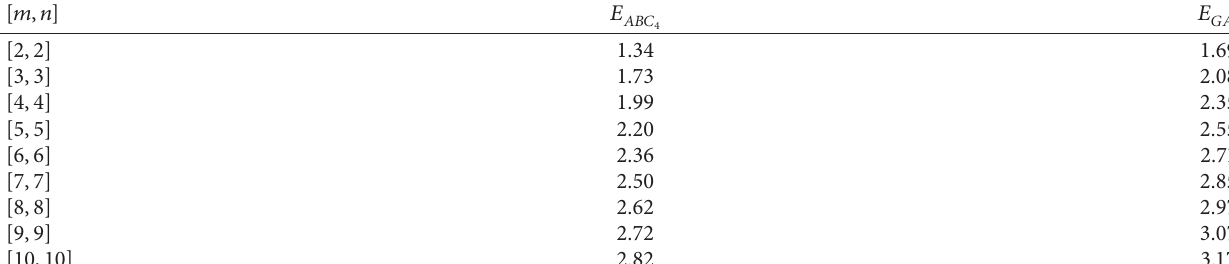
and GA entropies for Si 4 5